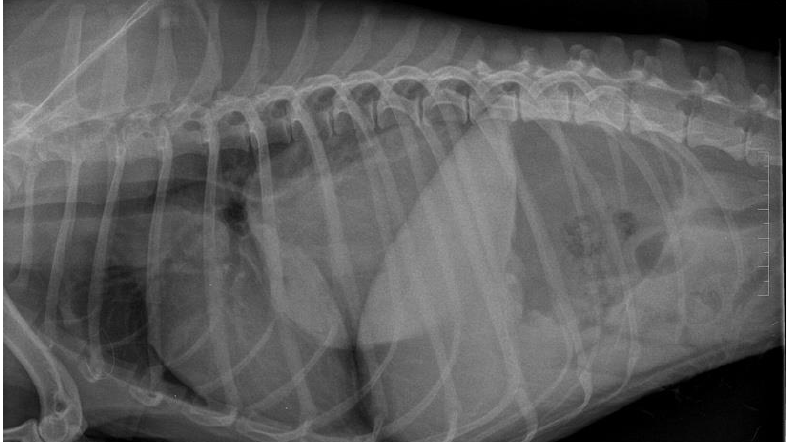
Figure 11. Lateral thoracic radiograph of a dog showing a large round shadow, occupying most of the caudal pulmonary field. The shadow was diagnosed as a primary solitary lung neoplasm in autopsy and was identified as adenocarcinoma in the histopathological examination.